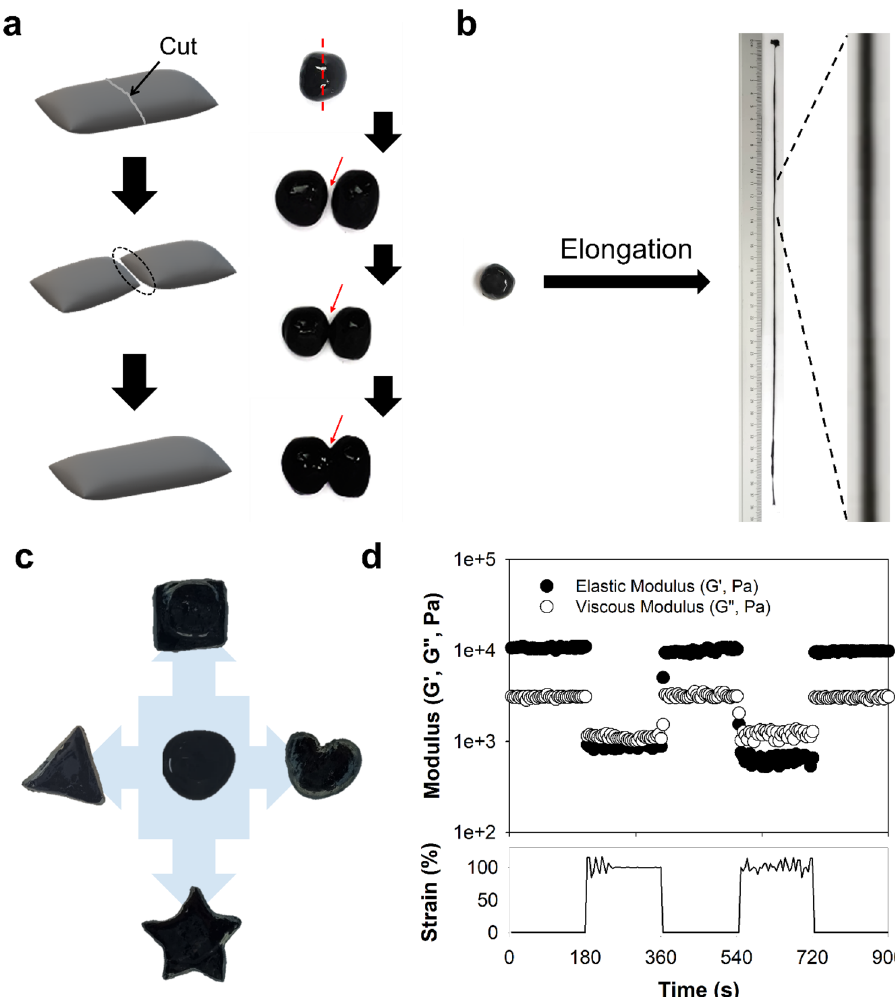
Figure 3. ( a–c ) Photographic images of CB/Alg-PBA/PVA hydrogels containing 2 mg CB to show ( a ) self- healing, ( b ) extensible, and ( c ) re-shapeable properties. ( d ) Step-strain measurements of CB/Alg-PBA/PVA hydrogels.